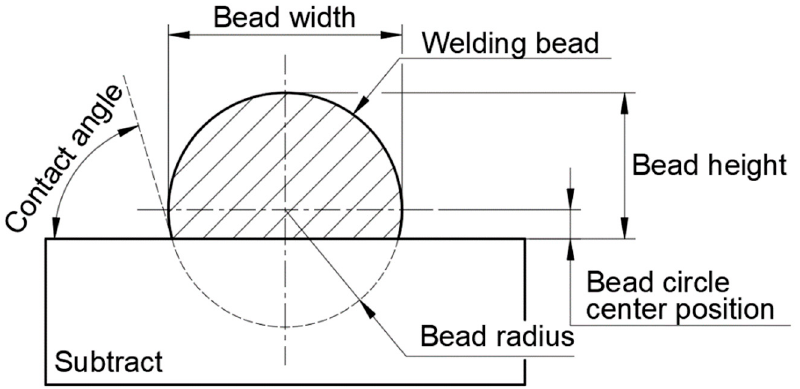
Figure 5. Definition of measurement points on bead cross-section.